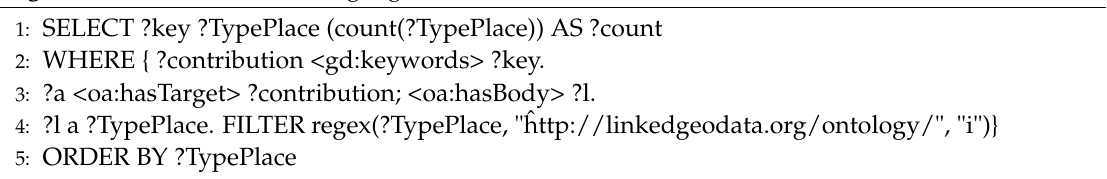
Algorithm 5 Q4 in SPARQL language.